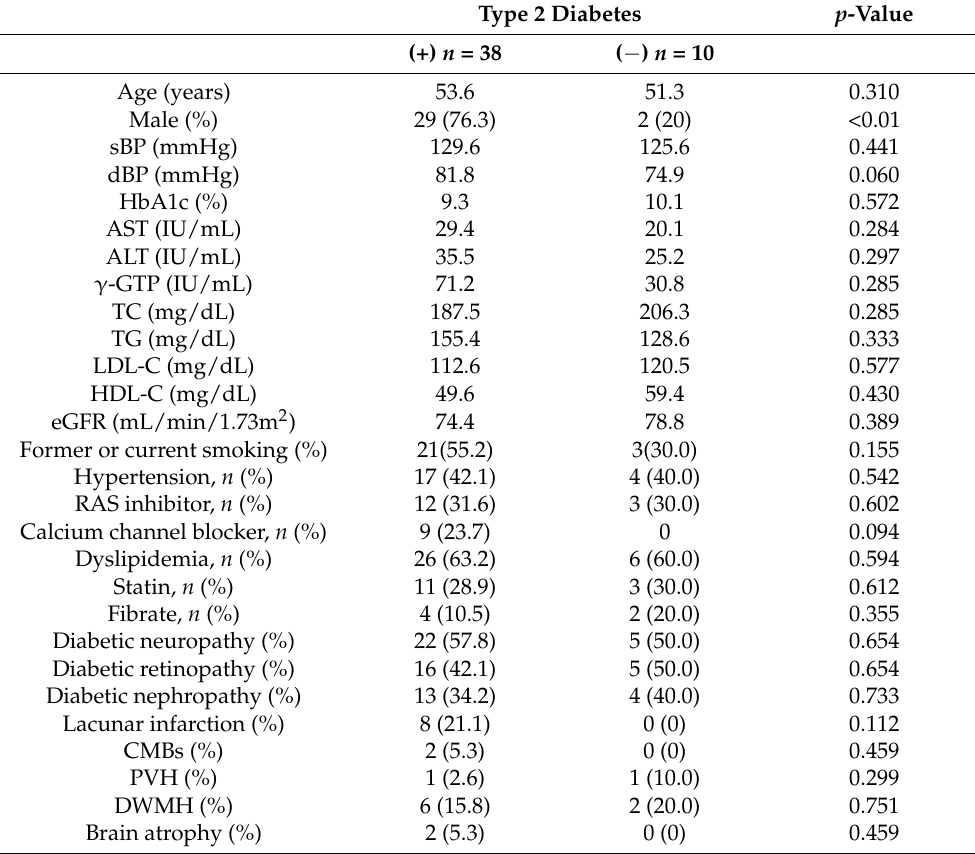
Table 4. The risk factors of plaque presence in both anterior and posterior circulation in T2D